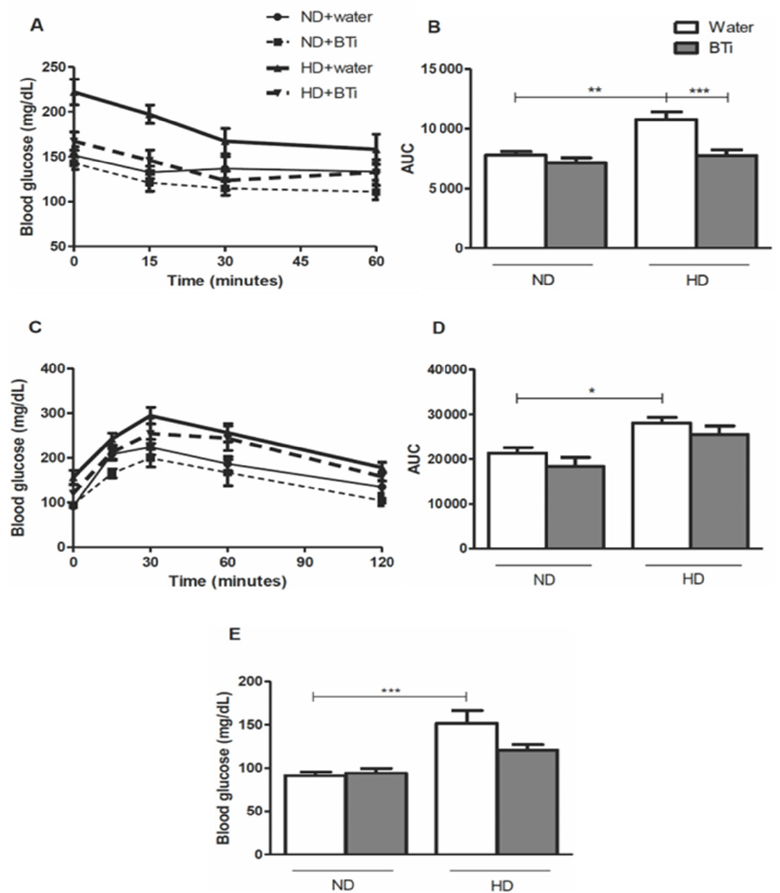
Figure 1. Effect of BTi on the glycemic profile of animals. ( A ) Glycemia values for Insulin sensitivity curve, according to the experimental group, at each time. ( B ) Area under the insulin sensitivity curve, according to the experimental group. ( C ) Glycemia values for oral glucose tolerance curve, according to the experimental group, at each time. ( D ) Area under the oral glucose tolerance curve, according to the experimental group. ( E ) Fasting glycemia. Results represents mean ± S.E.M. n = 8 animals/group. ND: normolipid diet. HD: high-fat diet. BTi: infusion of B. trimera . * p < 0.05. ** p < 0.01. *** p < 0.001. ANOVA, followed by Tukey post-test.